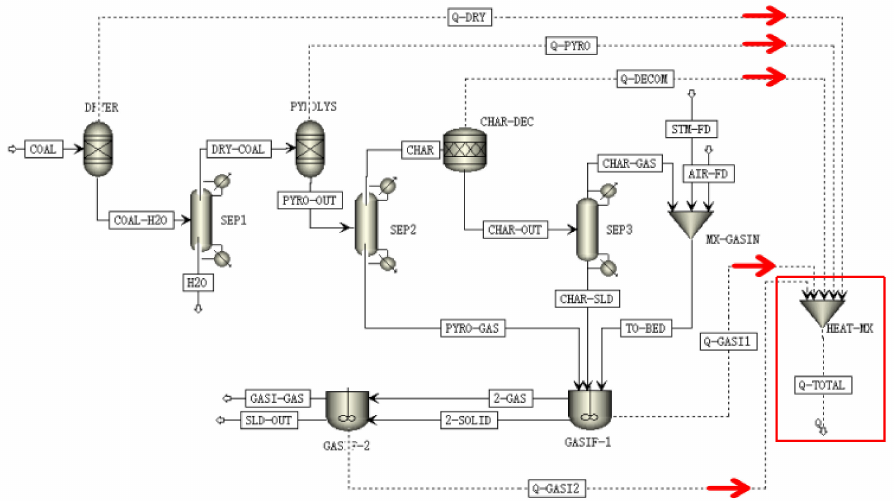
Figure 13. Heat transfer flow chart in the